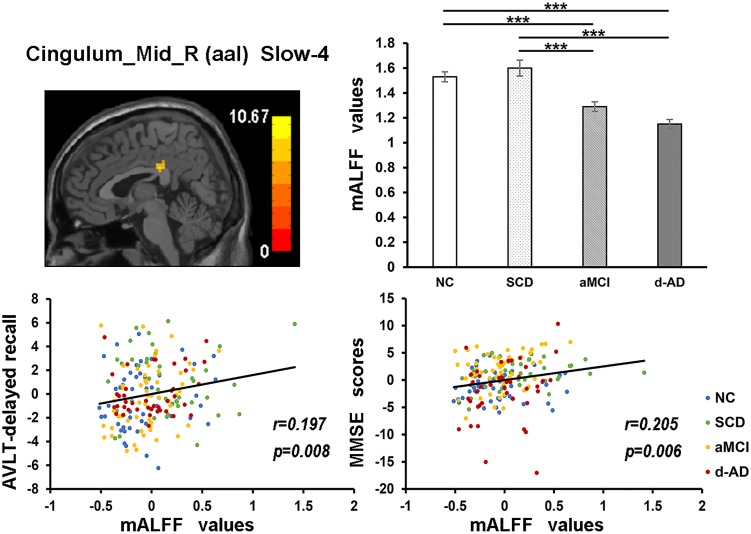
The correlation between mALFF values of the Cingulum_Mid_R (aal) in slow-4 band and delayed recall of AVLT/MMSE scores. The row 1, column 1 showed the corresponding anatomic location of the right median cingulate and paracingulate gyri in the brain. The row 1, column 2 displayed significant differences of mALFF values of this region in slow-4 band among four groups obtained by post hoc test (Bonferroni correction, P < 0.05). ∗∗∗ means significant level P < 0.001. The row 2 were scatter plots demonstrating the positive correlation between the right median cingulate and paracingulate gyri and delayed recall of AVLT/MMSE scores (Bonferroni correction, P < 0.05/5). Corresponding correlation coefficient “r” and significant level “p” were marked. NC, normal controls; SCD, subjective cognitive decline; aMCI, amnestic mild cognitive impairment; d-AD, dementia of Alzheimer’s disease; AVLT, the auditory verbal learning test; MMSE, the Mini–Mental State Examination.